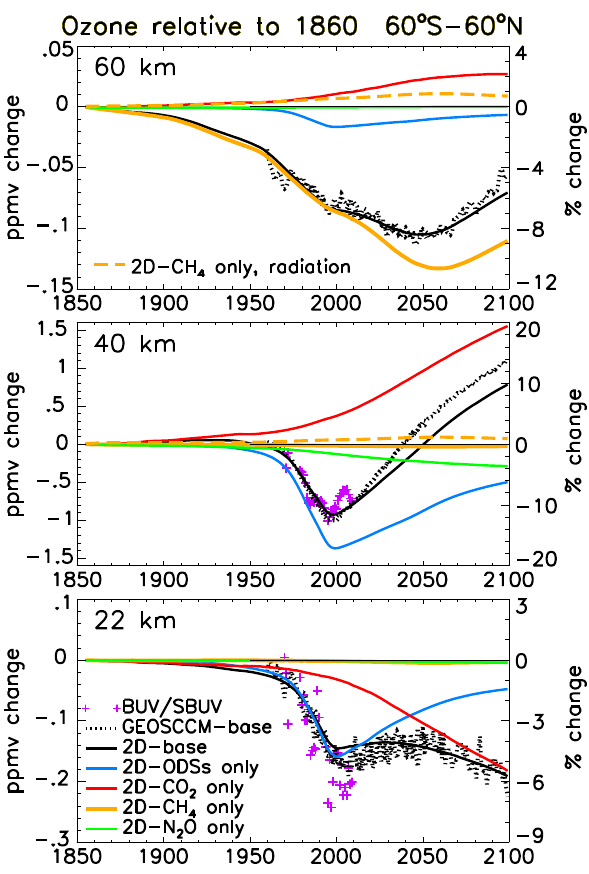
Fig. 5. Near global (60 ◦ S–60 ◦ N) annually averaged ozone time series for 1860–2100, relative to 1860, at 22, 40, and 60 km. Values are in ppmv change (left axes) and % change (right axes). Shown are the base simulations (all source gases varied time dependently) of the GEOSCCM (black dotted lines) and 2-D model (black solid lines), along with 2-D simulations in which only certain source gases are varied as follows: ODSs only (blue solid); CO 2 only (red solid); CH 4 only (orange solid); and N 2 O only (green solid) (the other source gases are fixed at 1850 levels in these simulations). Also shown is a 2-D simulation in which only the radiative impacts of CH 4 are included (orange dashed). The GEOSCCM time series has been adjusted to match the 2-D base simulation for 1960. Also shown are the BUV/SBUV satellite observations for 1970–2009 (excluding 1973–1978) at 22 and 40 km (“ + ” symbols). To emphasize the model-data comparison after 1970, the data have been adjusted so that the 1970–1972 average matches that of the base simulations.